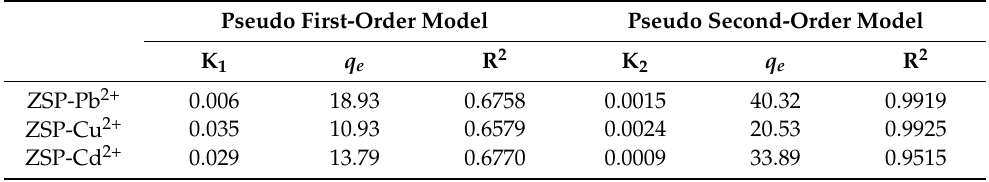
Table 1. Kinetic model parameters.